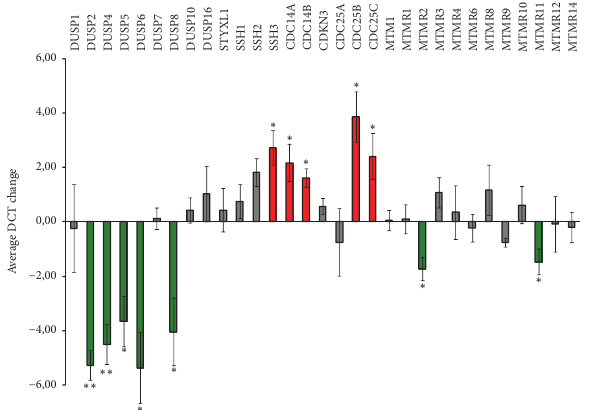
Figure 3: Expression change of NCs phosphatases induced by the PI treatment. The graph represents the average of the change in DCT betweenTh1andTh1-PIcells.Genesupregulatedanddownregulated are labelled in green and red, respectively. Assessment of regulated genes is explained in materials and methods. ∗∗ 𝑝 < 0.01 and ∗ 𝑝 < 0.05 correspond to the probability of paired 𝑡 -test used in comparison of the DCT values obtained in Th1 and Th1-PI cells from 3